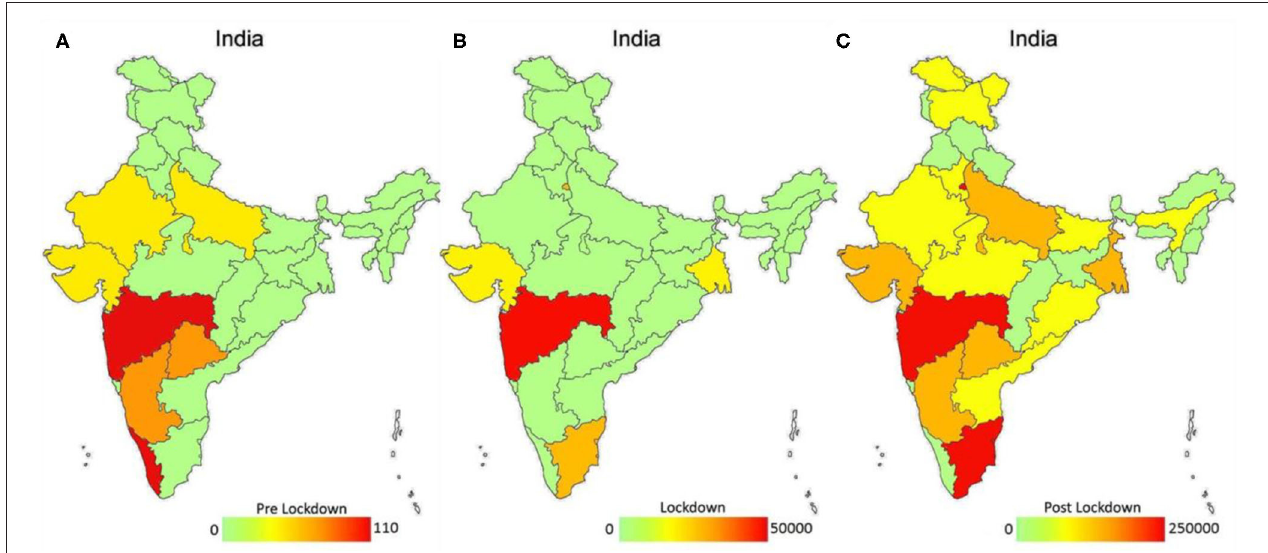
FIGURE 1 | Spatial distribution of COVID-19 reported confirmed cases under the effect of lockdown in India (A–C) . Color bar represents the spatial variation of confirmed cases from lowest (green color) to highest (red color) under three phases of lockdown i.e., pre-lockdown (A) , during lockdown (B) and post-lockdown (C) in